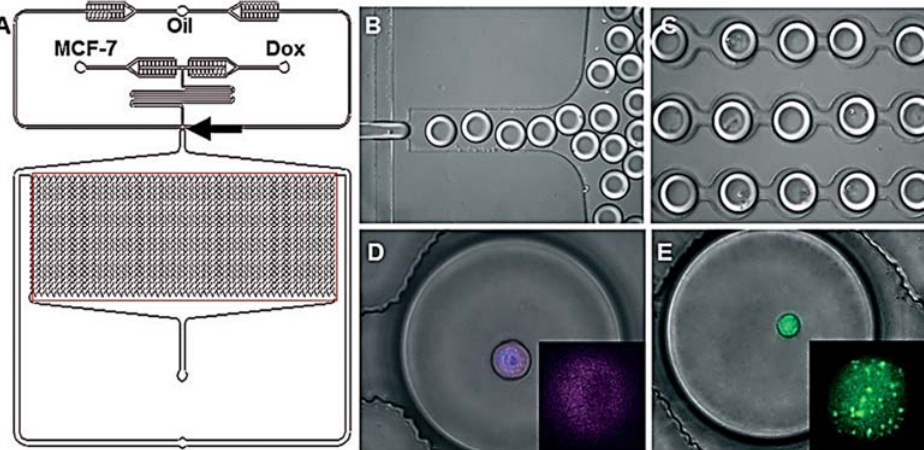
Figure 6. Schematic diagram of single-cell encapsulation in droplets by Microfluidic chip: ( A ) Mi- crofluidic chip, arrows are droplet generation junctions, and boxes indicate droplet docking arrays. ( A ) Microfluidic chip, arrows are droplet generation junctions, and boxes indicate droplet docking arrays. ( B ) Droplet generation. ( C ) Microdroplet docking. ( D ) Detection of Cy-5 conjugated ABCB-1 mRNA in live MCF-7S cells in droplet (enlarged in inset), Hoechst labeled cells nuclei. ( E ) Dox- resistant MCF-7R cell encapsulation in droplet. Inset: Calcein AM localization in vesicles. The image from [47], Copyright 2015, Royal Society of Chemistry.